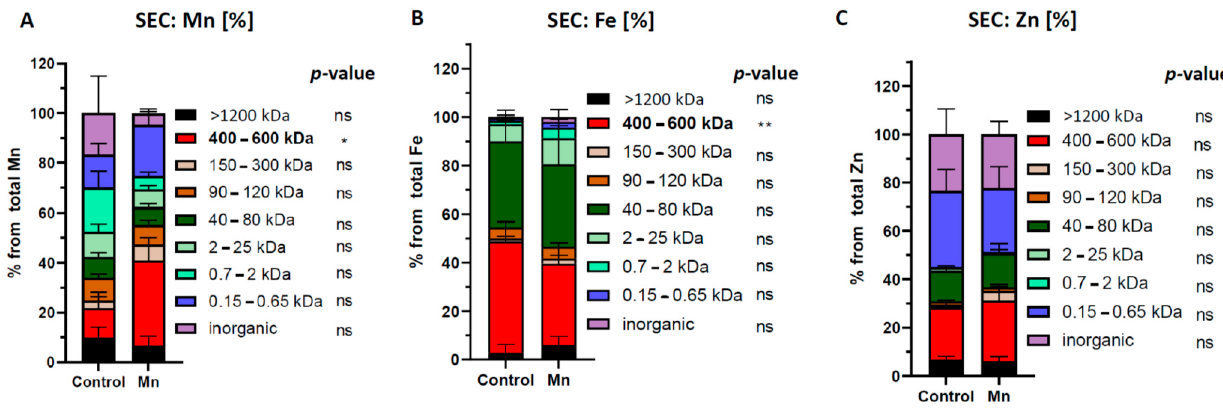
Figure 4. Comparison of relative element distribution in size fractions from brain extracts of control or orally Mn-exposed rats (backup samples from [55] were used). ( A ) Following Mn exposure only the Mn concentration of the 400–600 kDa fraction (containing α -2-macroglobuline) is significantly increased compared to controls (n = 6). ( B ) In Mn-treated brain samples the Fe concentration in the 400–600 kDa fraction (containing ferritin) is significantly decreased compared to controls (n = 6). ( C ) No significant changes between control and Mn-exposed brains were observed in Zn-containing fractions (n = 6). Differences were calculated using two-way ANOVA followed by Bonferroni post hoc analyses (* p < 0.05; ** p < 0.01). ns = not significant.